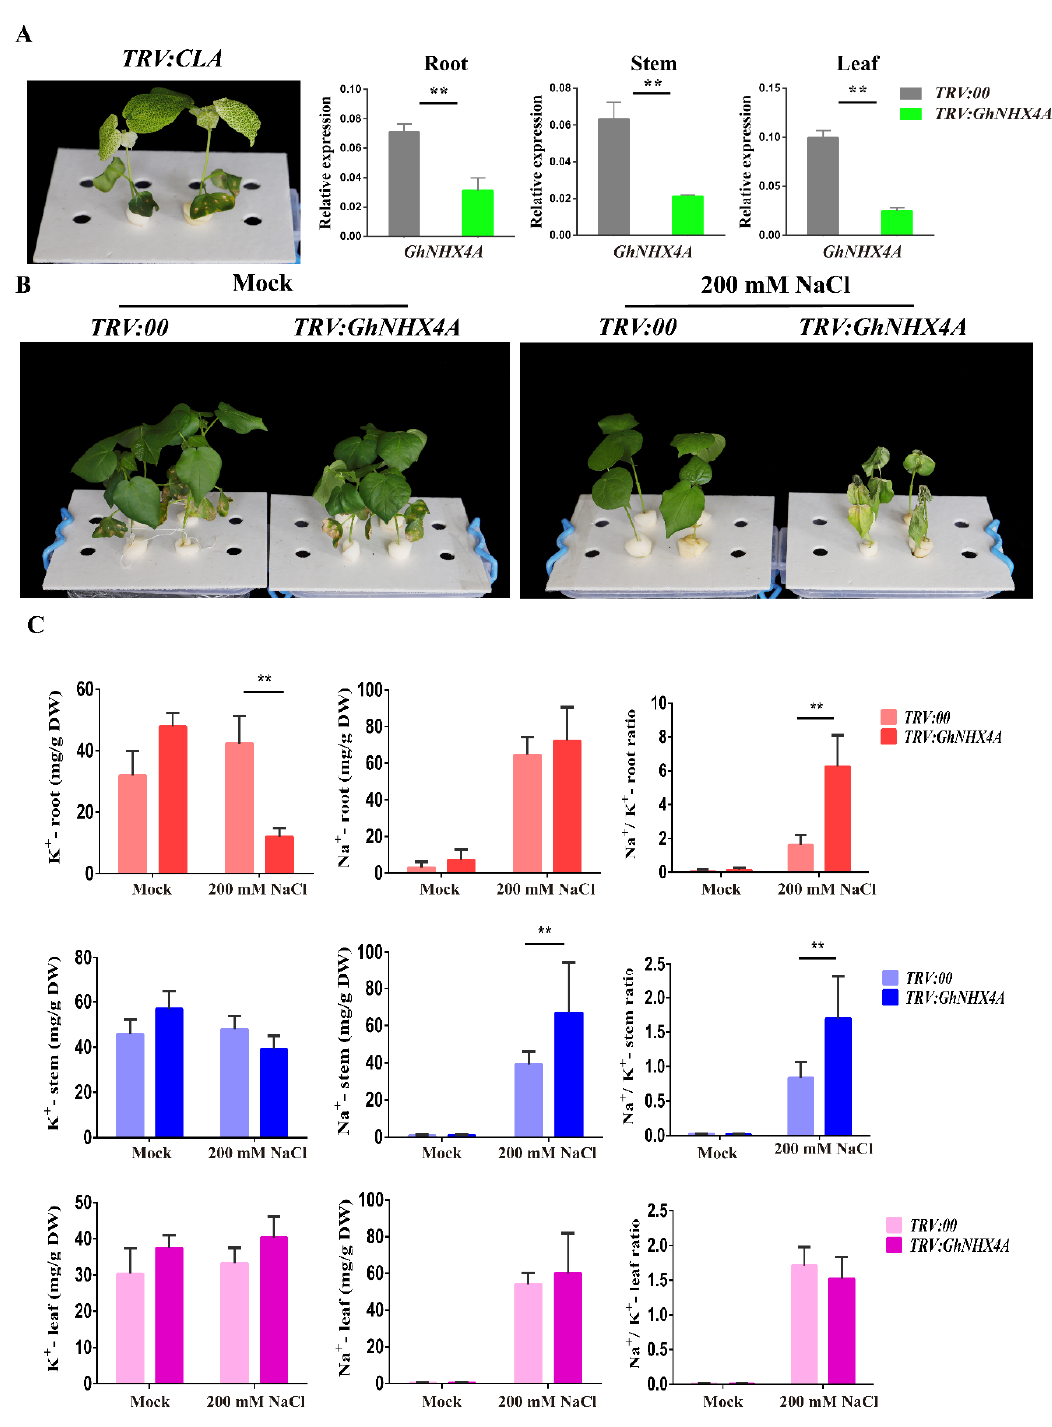
Figure 7. Functional analysis of GhNHX4A in cotton response to salt stress. ( A ) Gene silencing e ffi ciency of TRV:00 and TRV:GhNHX4A . TRV:CLA was used as the positive control, and GhHIS3 served as the internal reference gene. Error bars indicate the standard deviation of at least three biological replicates (** p < 0.01; t -test). ( B ) Representative images of TRV:00 and TRV:GhNHX4A plants treated with water (mock) or 200 mM NaCl. ( C ) Na + and K + contents and Na + / K + ratios of the TRV:00 and TRV:GhNHX4A plants treated with water (mock) or NaCl. Red, blue, and purple refer to the roots, stems, and leaves, respectively. Error bars indicate the standard deviation of at least three biological replicates (** p < 0.01; t